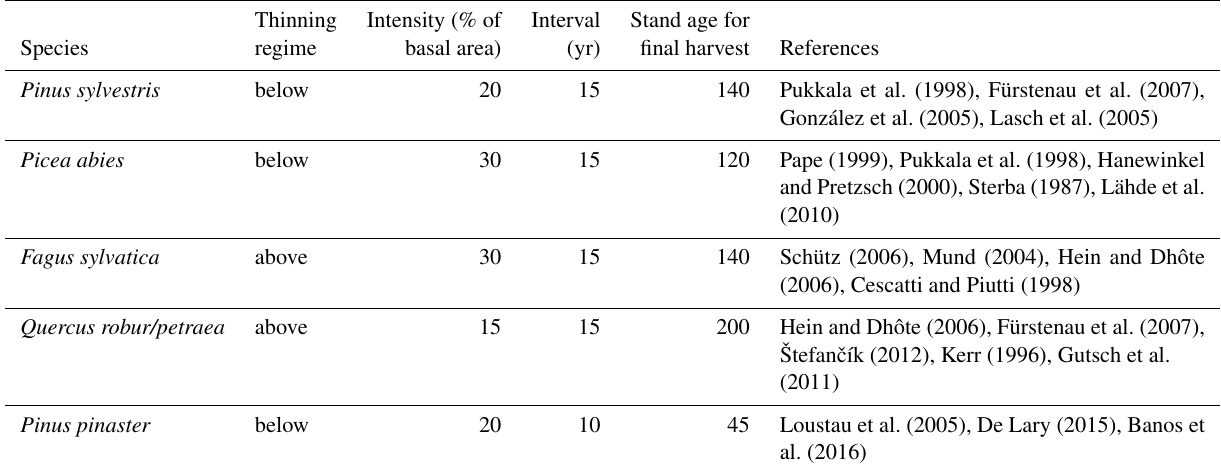
Table 7. Generic future management scenarios for the main tree species featured in the PROFOUND